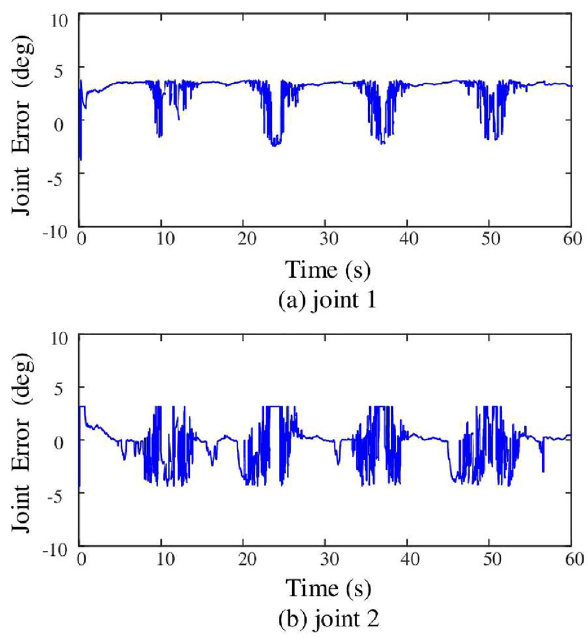
Fig.10 Joint positionerror curves under existingdecentralizedintegral sliding mode control